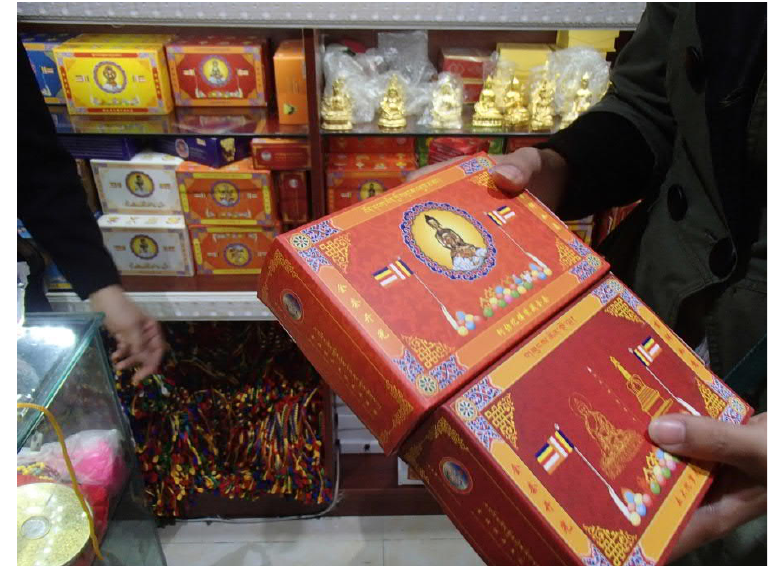
Figure 4. Consecration-kits for